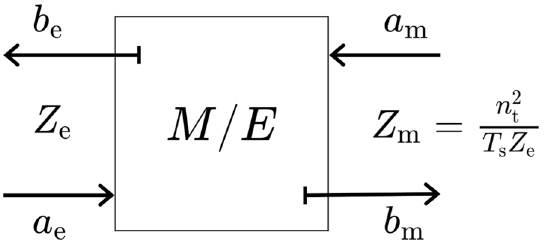
Fig. 3 ME junction showing adapted ports symbolically represented by a T-shaped stub. The magnetic port resistance is set according to the adaptation condition given in